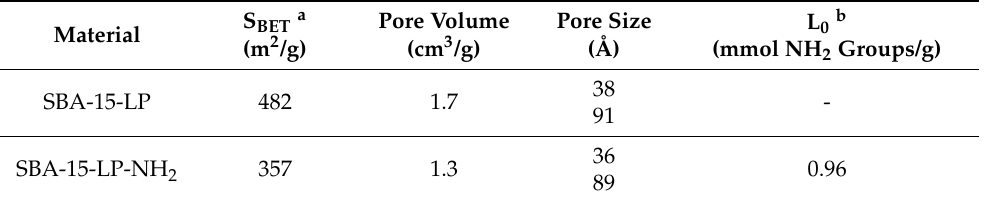
Table 2. Textural properties of the prepared materials and functionalization degree of SBA-15-LP-NH 2 . Material